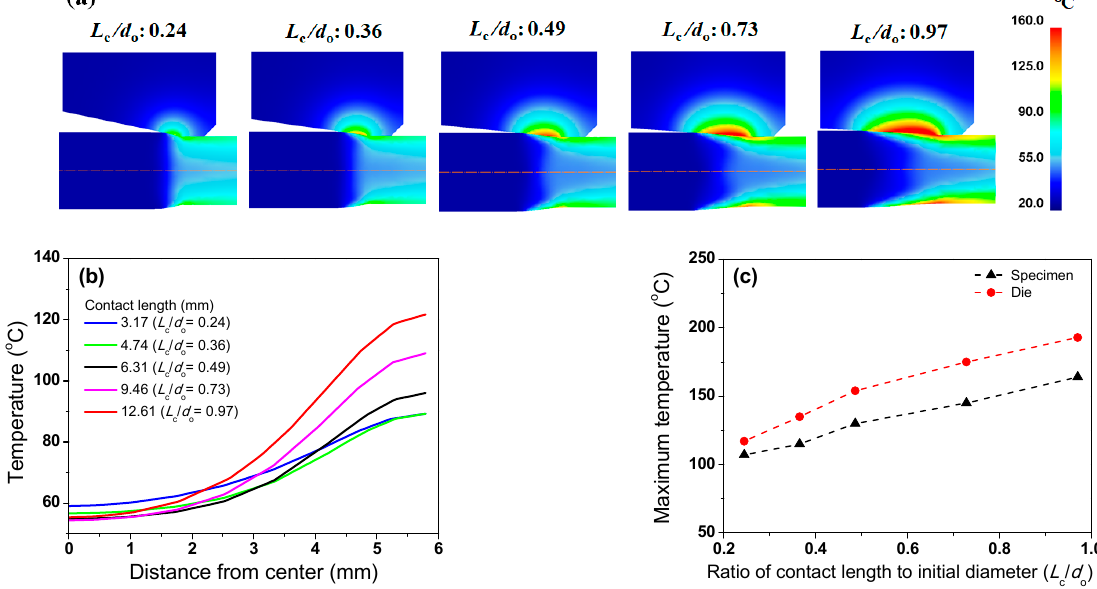
Figure 9. Comparison of temperature ( a ) contours and ( b ) profiles along radial direction of wire at die exit; ( c ) T max of wire and die vs. contact length.